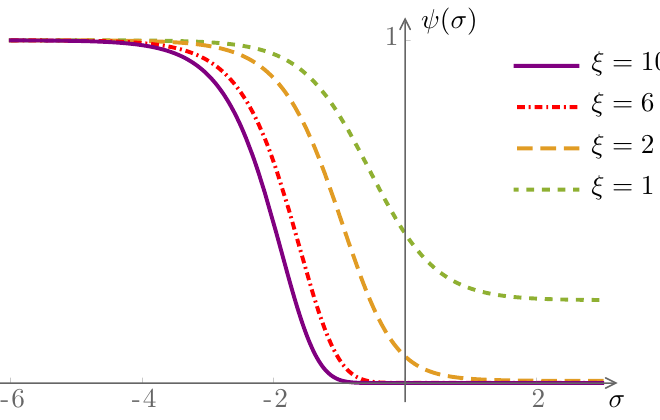
Figure 10 . Numerical plot of the ground state wave function (normalised to unity at (cid:27) = (cid:0)1 ), for zero spins, twist angles ( (cid:18) 1 ; (cid:18) 2 ) = (4 = 3 ; 1 = 2) and coupling constants (cid:24) = 1 (green), (cid:24) = 2 (orange), (cid:24) = 6 (red), (cid:24) = 10 (purple). For zero spins, the wave function is not decaying but asymptotically constant at in(cid:12)nity. As we will discuss in more detail in section 4.4, it becomes more and more localised around (cid:27) = (cid:0)1 as the coupling